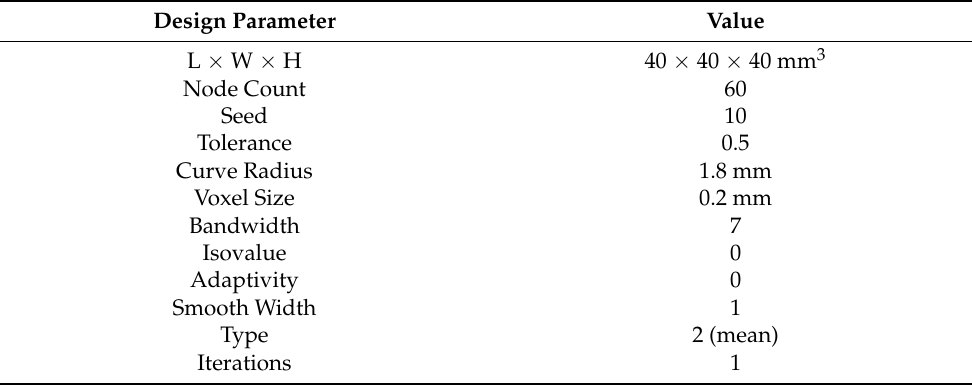
Table 2. Complete set of design parameters for the 3D-printed